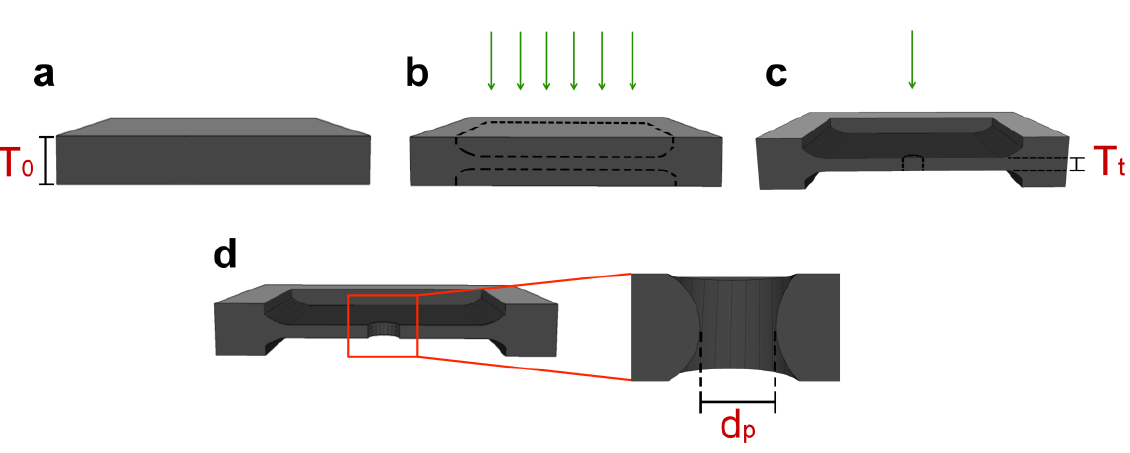
; ( b ) Patterned ion beam exposure o ; Exposure of a t p